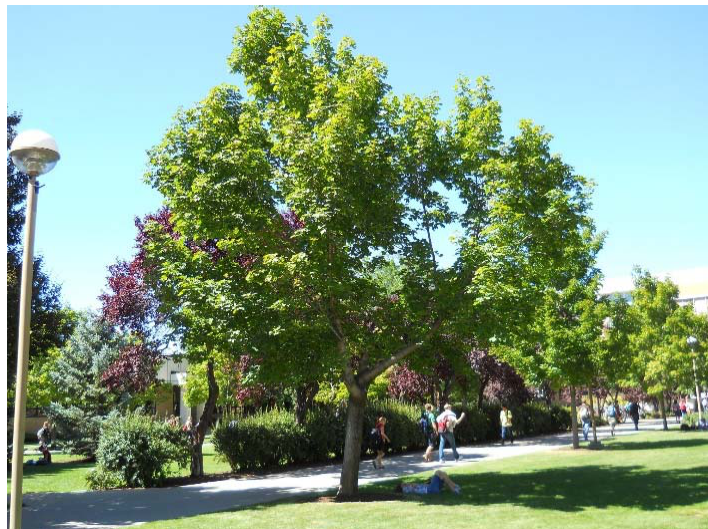
Figure 7. Image of a small Norway Maple tree along a sidewalk on the Brigham Young University campus. As a result of the loss of a major limb on the backside due to storm damage, the tree canopy is concentrated on the forward side of the trunk in the direction of the camera. See Figure 8.